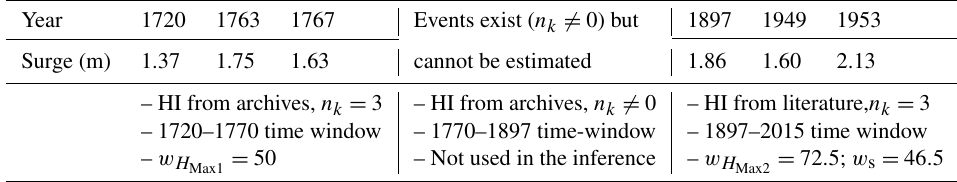
and w s in years. Max